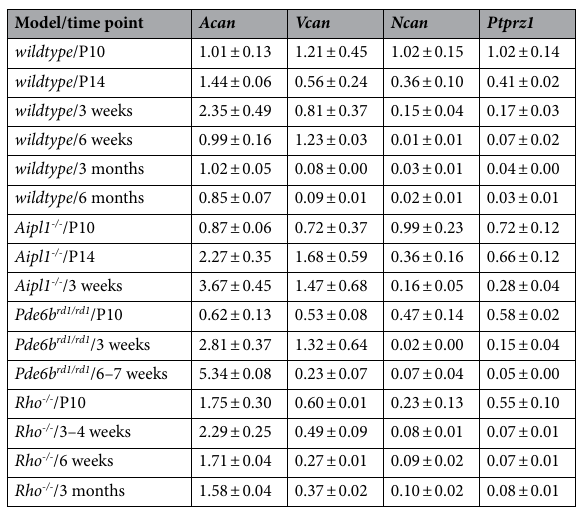
Table 2. Relative values of Acan , Vcan , Ncan and Ptprz1 mRNA expression across time and models. Data shown is fold change ± SEM, relative to wildtype at